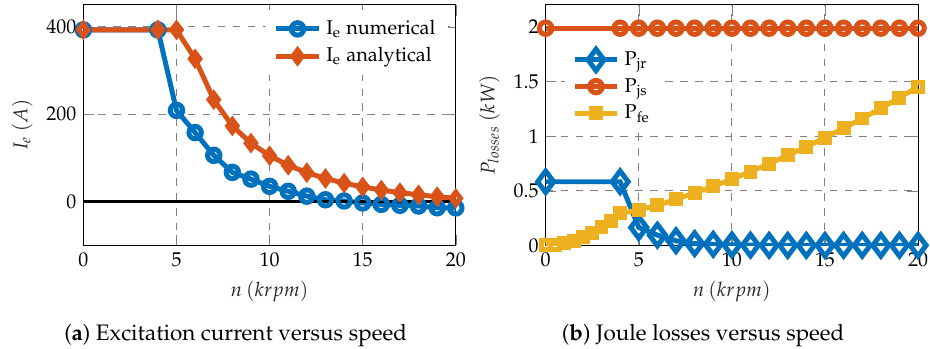
Figure 10. Rotor excitation current and joule losses of PRC-6 motor.